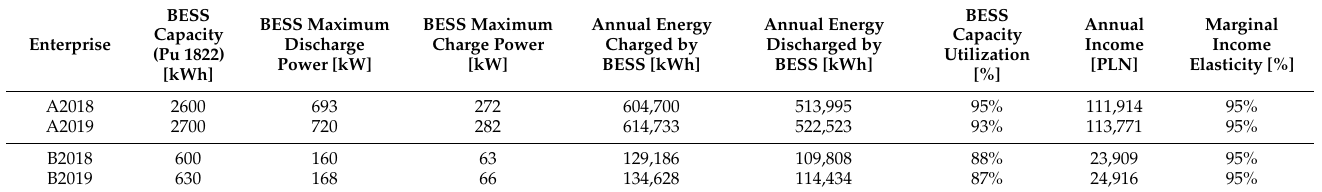
Table 7. Numerical results of the price arbitrage simulation for the A2018